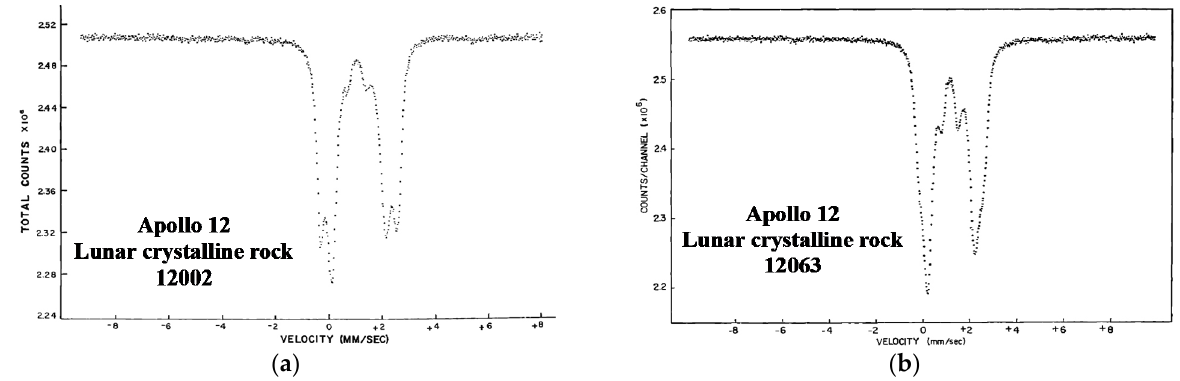
Figure 42. Mössbauer spectra of Lunar crystalline rocks (Apollo 12) measured at room temperature in transmission geometry: specimen 12002 ( a ) and specimen 12063 ( b ). Adapted from [105].